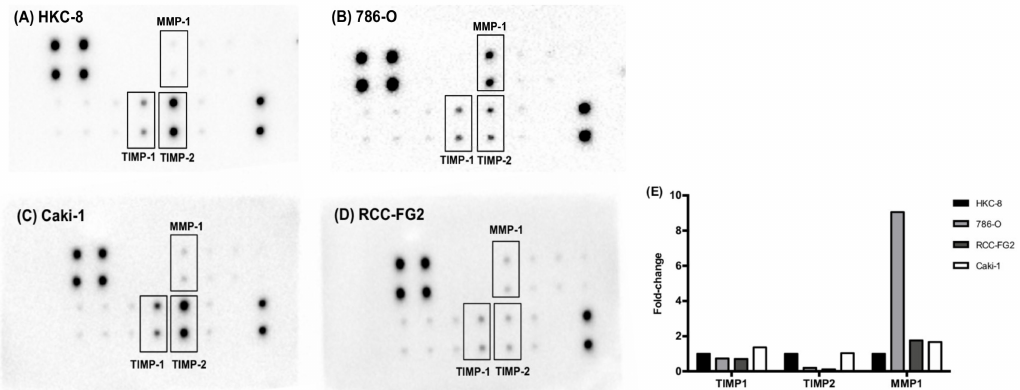
Figure 2. Human MMP Antibody Array analysis in cell-derived EVs. Membranes were probed with EV lysate from ( A ) HKC-8, ( B ) 786-O, ( C ) Caki-1 and ( D ) RCC-FG2 cells. MMP, matrix metalloproteinases; TIMP, tissue inhibitor of metalloproteinase; Pos, positive control; Neg, negative control. ( E ) Fold-change of the pixels volume adjusted